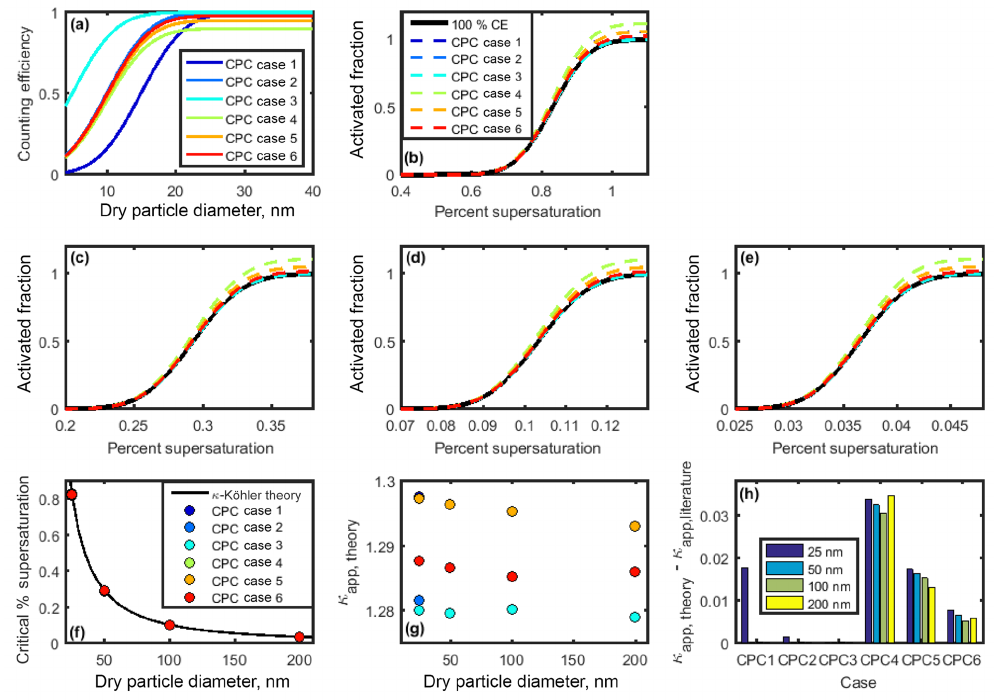
Figure 7. (a) Counting efficiency curves for CPC cases 1–6 (shown in Table 3). (b–e) CCN activated fraction curves for 25, 50, 100, and 200nm NaCl, respectively. (f) Critical supersaturation calculated for each particle diameter. (g) Theoretical κ app for each CPC case and particle diameter. (h) Artifacts in κ app for each CPC case and particle diameter.